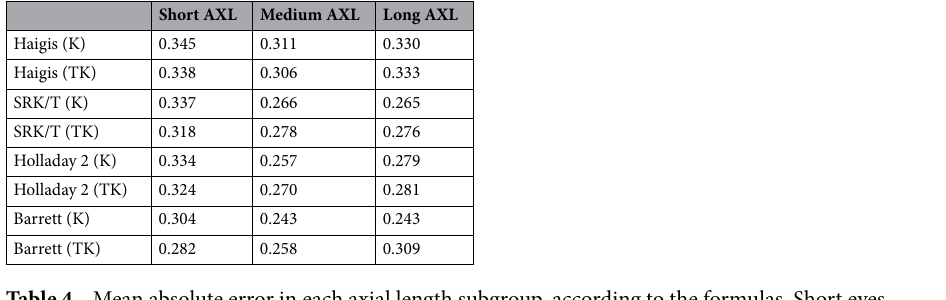
Table 4. Mean absolute error in each axial length subgroup, according to the formulas. Short eyes (< 22.5 mm); medium eyes (22.5–25.5 mm); long eyes (> 25.5 mm). K conventional keratometry, TK total keratometry, AXL axial